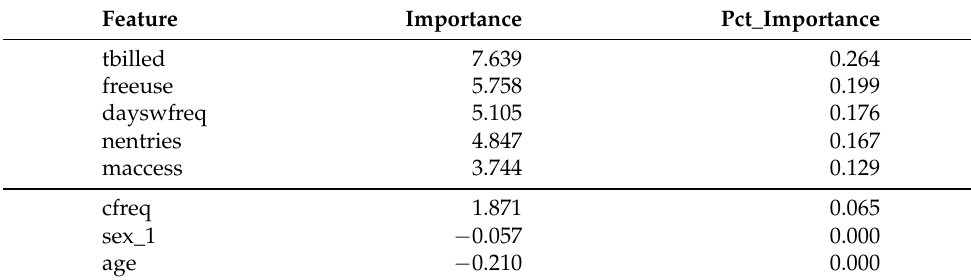
Table 3. Feature importance in the survival model.